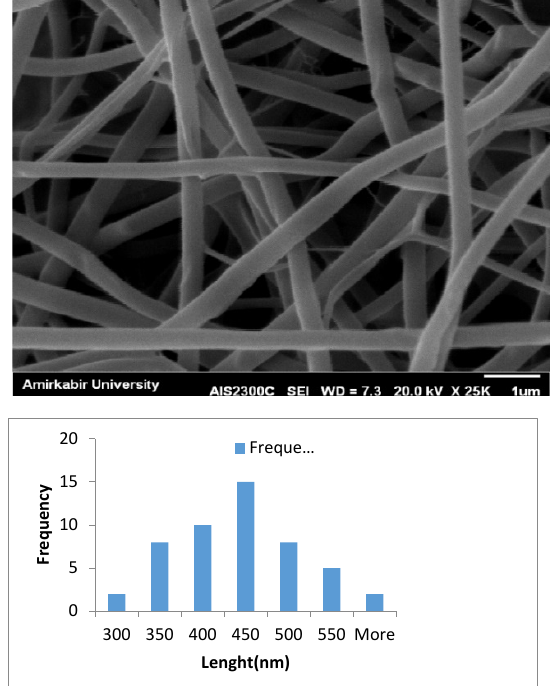
Fig. 3. SEM image of PVA/CS electrospun nanofibers after crosslinking process, average nanofibers diameter (420 nm)